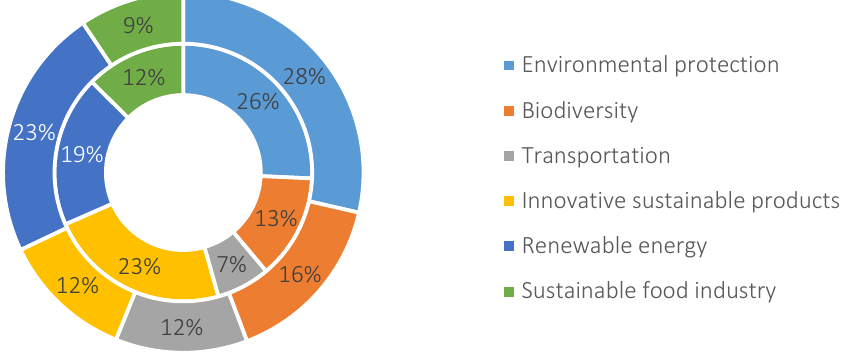
Figure 3. Sectoral investment interest of residential (outer arc) and corporate (inner arc) respondents (June 2022)